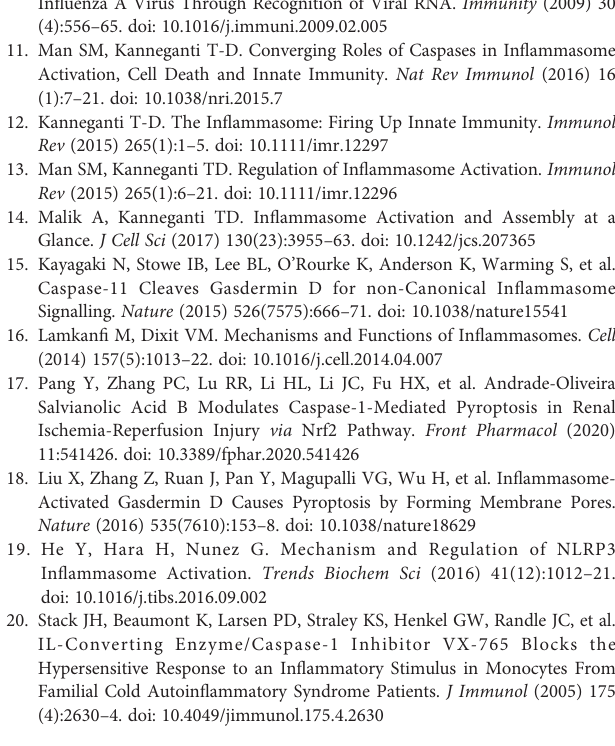
Supplementary Figure 1 | Effect of cigarette smoke on NLRP3 in fl ammasome, and potential therapeutic strategies. HMGB, high mobility group box 1; NAC, N- Acetyl-L-cysteine; ROS, reactive oxygen species; TRP, transient receptor potential protein; ER, endoplasmic reticulum; NLRP, Nucleotide binding oligomerization domain and leucine-rich repeat containing